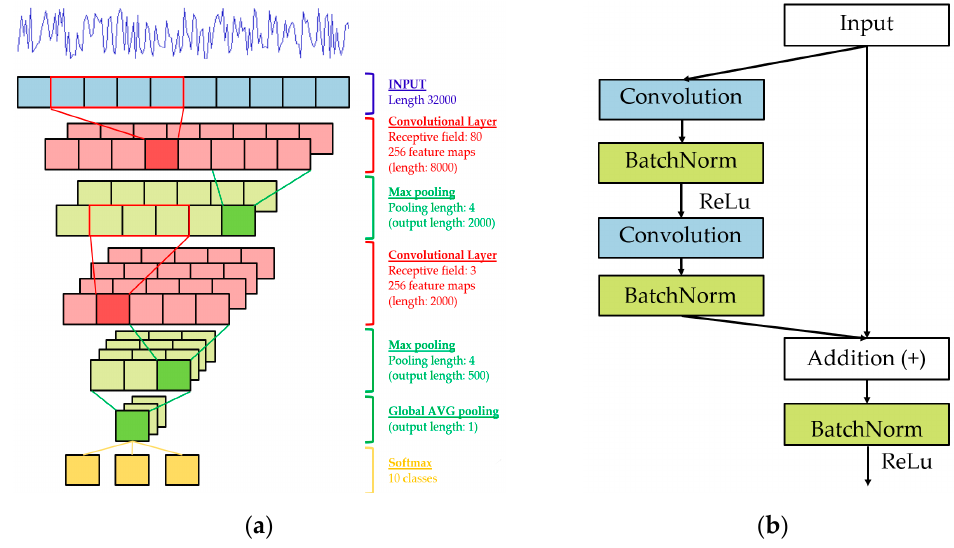
Figure 11. Convolutional neural network architecture: ( a ) The architecture of the model in which the audio input is represented by a single characteristic map / channel. In each convolutional layer a feature map encodes the activity level of the associated convolutional kernel; ( b ) the residual block (res block) consists of two convolution